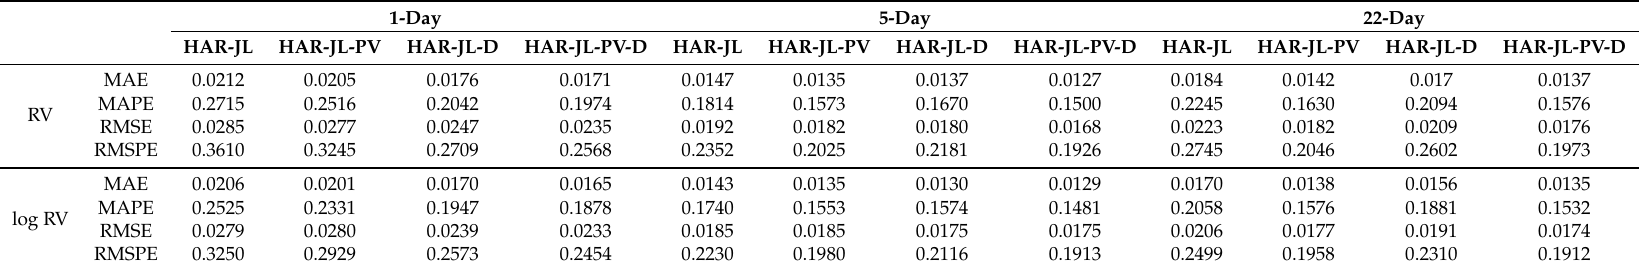
Table 3. Forecasing error of the realised volatility for the out-sample data from 1 January 2014 to 31 December